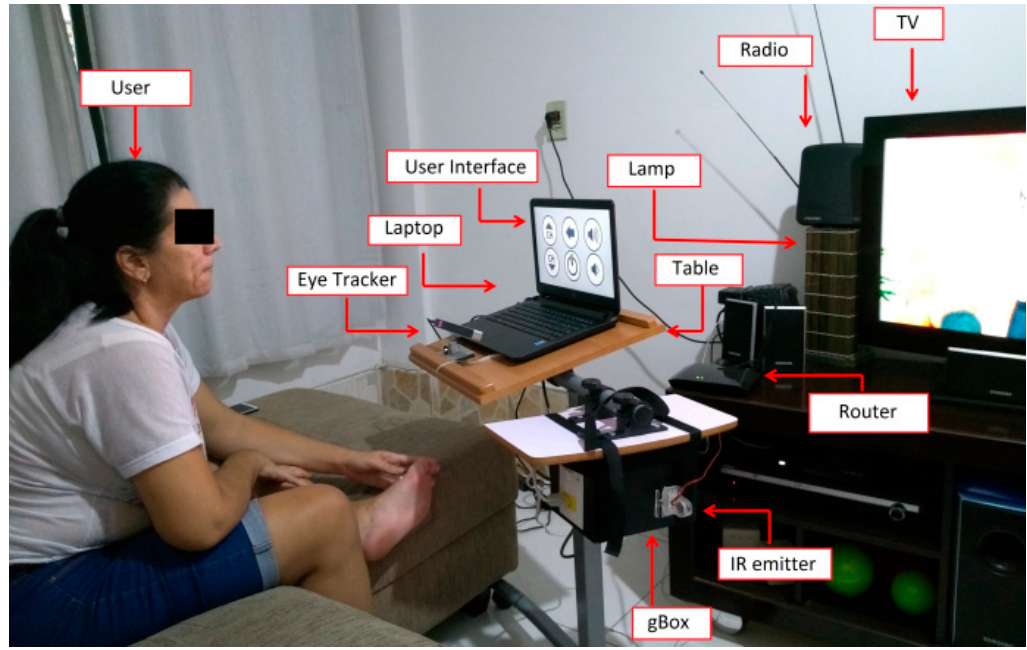
Figure 10. Participant with disabilities testing the system at her